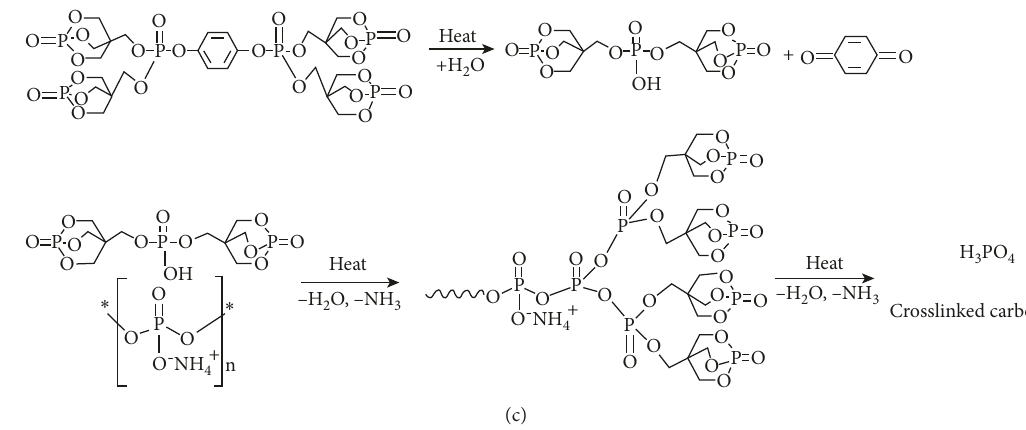
Figure 13: Formulas of the degradation mechanism of (a) IFR-PP (PER), (b) IFR-PP (PEPA), and (c) IFR-PP